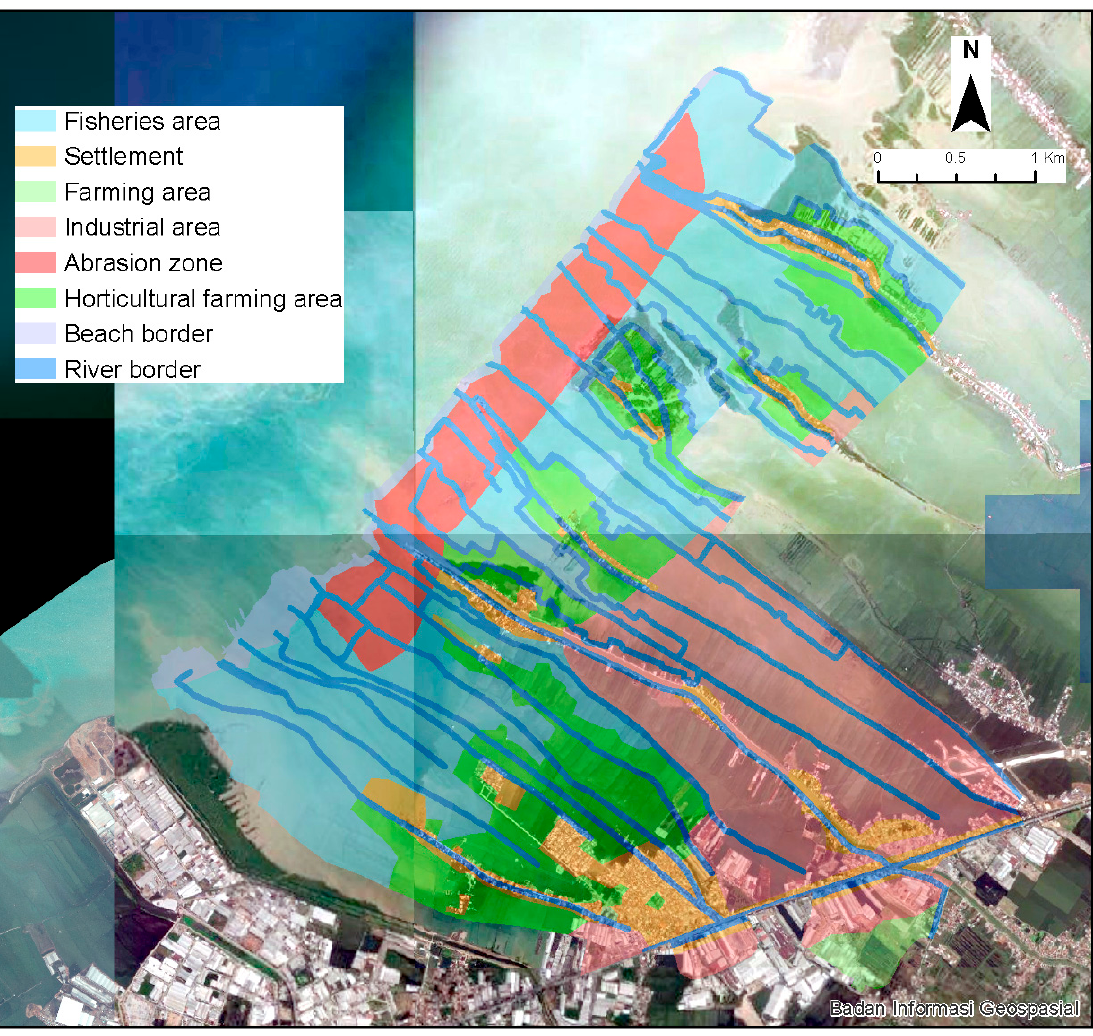
Figure 9. First version of spatial planning in the study area in the period of 2011–2031 (before revision). In this version, the frontline of the area was designated as abrasion zone, and industrial area located landward.